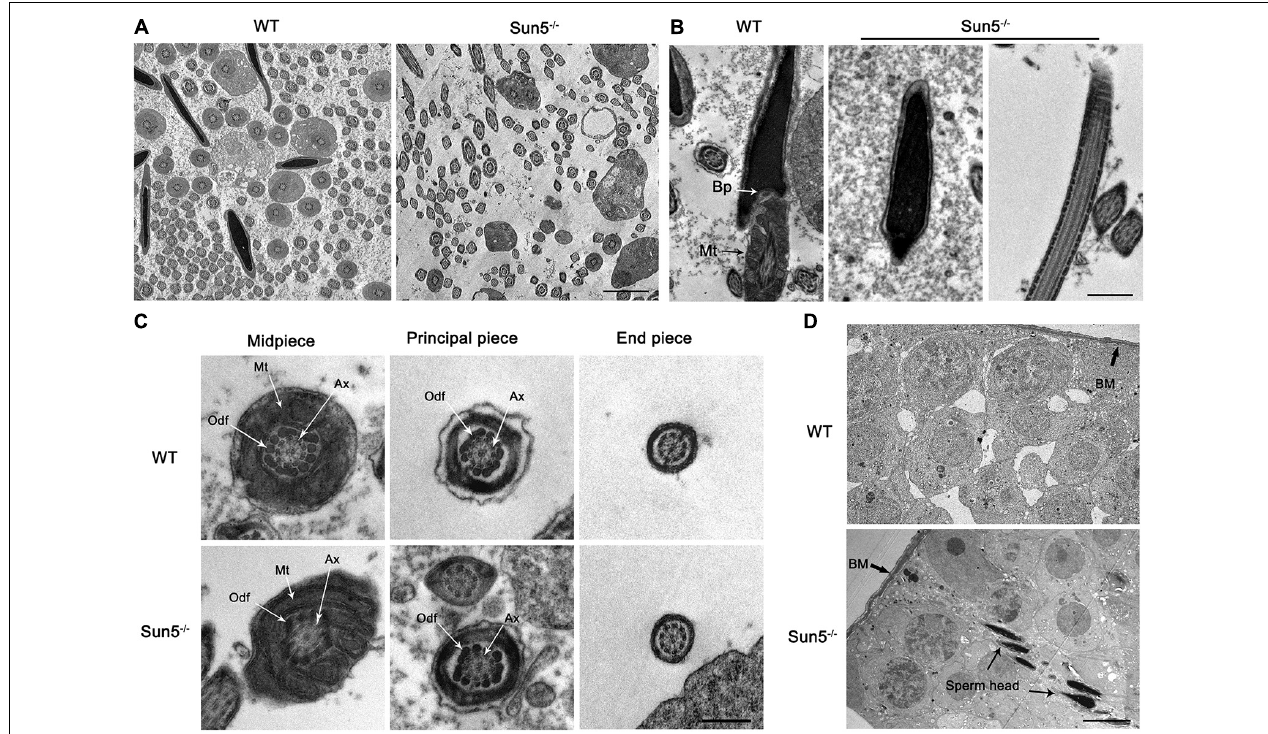
FIGURE 3 | Damaged HTCA of spermatozoa and disordered mitochondria in Sun5 − / − mice revealed by TEM. (A) Overall perspective of spermatozoa in the epididymal lumen. Bars: 10 µ m. (B) Longitudinal section of epididymal sperm in WT and Sun5 − / − mice. Bp, basal plate; Mt, mitochondria. Bars: 2 µ m. (C) The cross section of the midpiece, principal piece and end piece of the flagellum. Ax, axoneme; Odf, outer dense fiber. Bars: 200 nm. (D) The appearance of the head near the basement membrane (BM). Bars: 10 µ